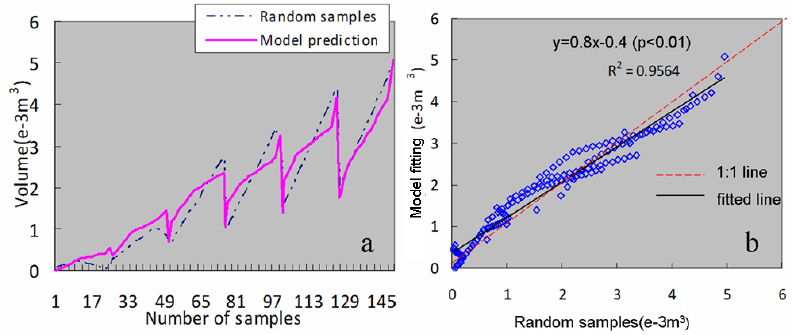
Figure11. The linear model (cumulative rainfall and eroded soil sediment): ( a ) random samples versus model fitting ( n = 147); ( b ) linear relationship between random samples and model fitting (RMSE = 1.2623) ( n = 147).